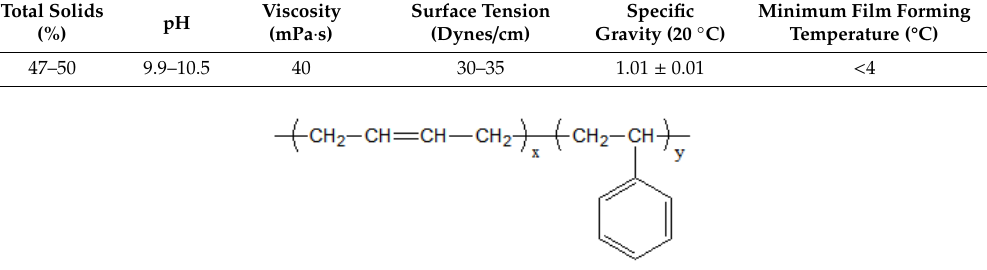
Figure 1. Chemical constitution of styrene–butadiene rubber (SBR) latex.